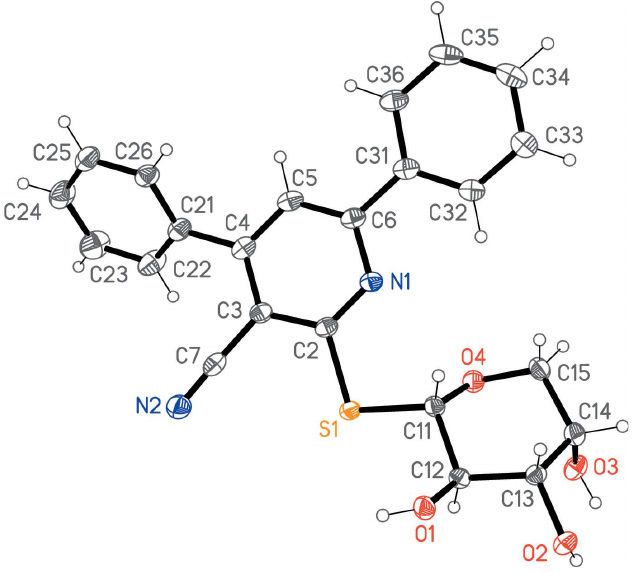
Figure 1 Structure of the title compound ( 4 ) in the crystal. Ellipsoids represent 50% probability